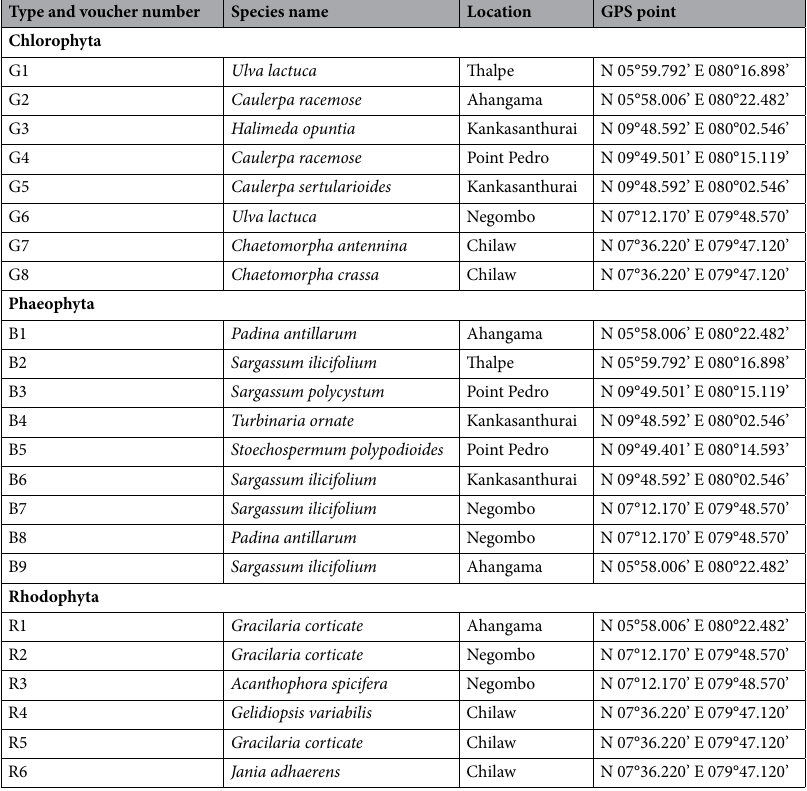
Table 1. Name of seaweed species, collected location and voucher